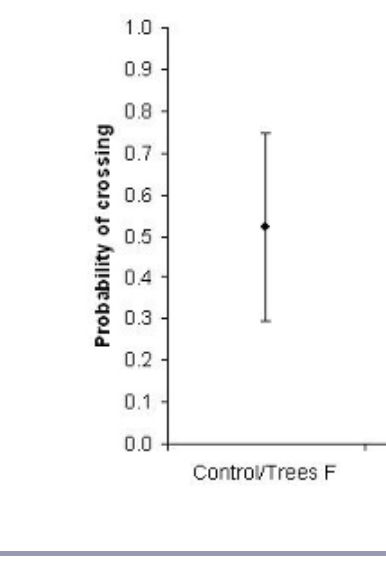
Fig. 6. Mean predicted probability that a squirrel glider ( Petaurus norfolcensis ) resident in habitat adjacent to a road will make a partial, i.e., verge to median or median to verge, or complete crossing at different site types. There was no significant difference in the likelihood that an individual will cross a secondary road or the dual-roadway Hume Freeway with trees in the median, and these are pooled (denoted Control/Trees). No Trees are sites at the Hume Freeway without trees in the median. Males and females are shown. Error bars are the 95% credible